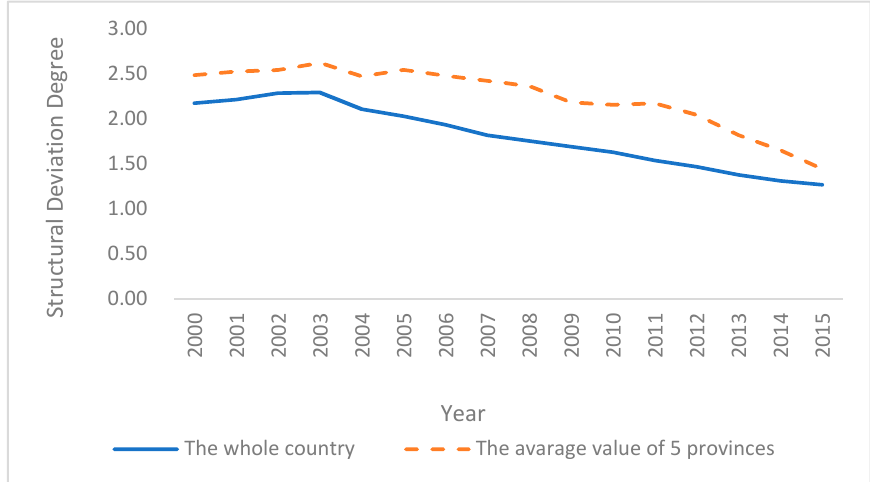
Figure 1. The degree of structure deviation.